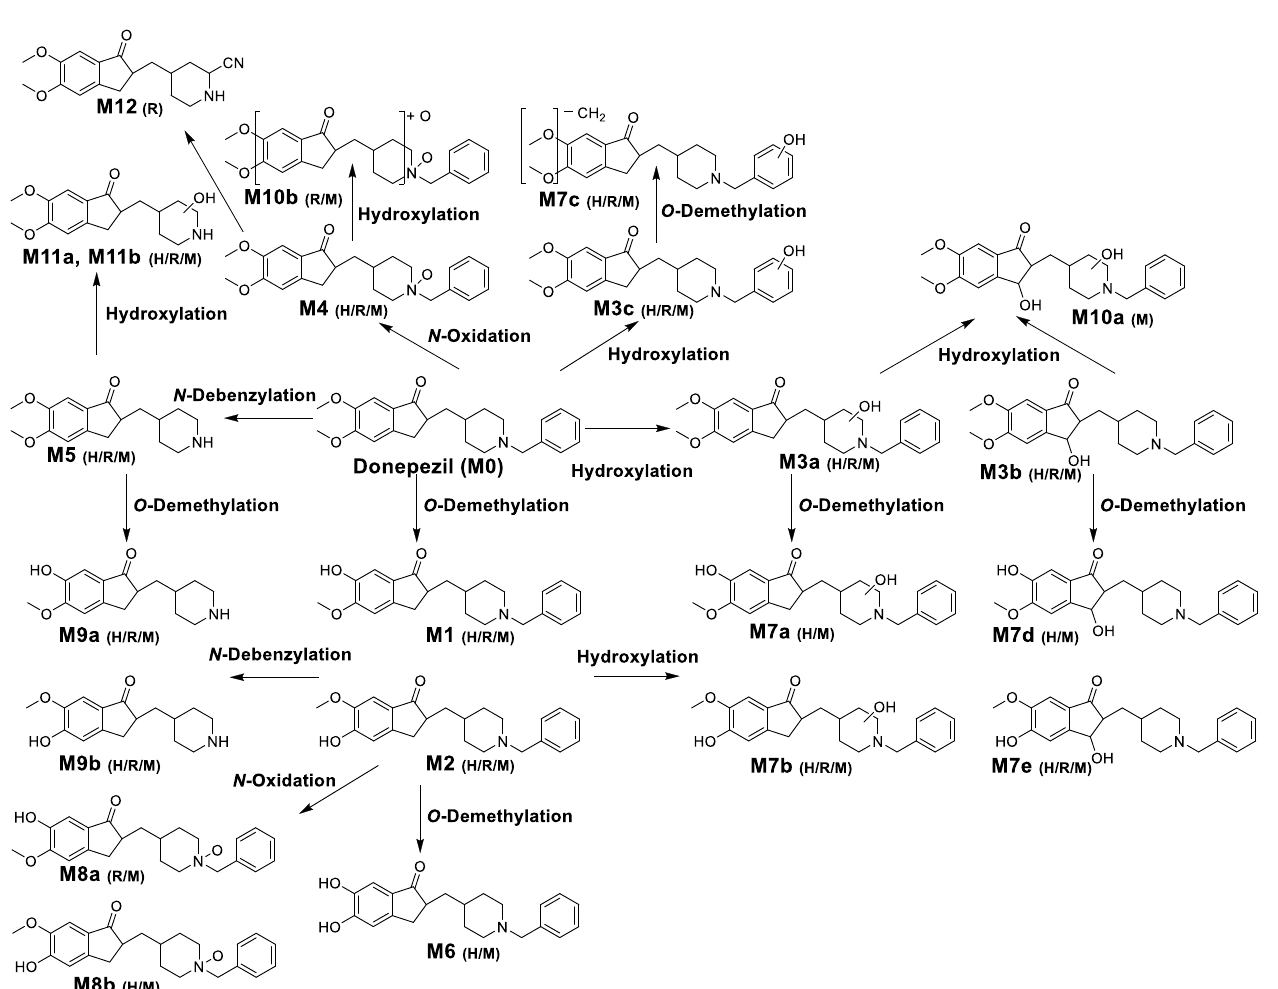
Figure 7. Chemical structure of donepezil showing locations of Phase I metabolic reactions and the bioactivation pathway.